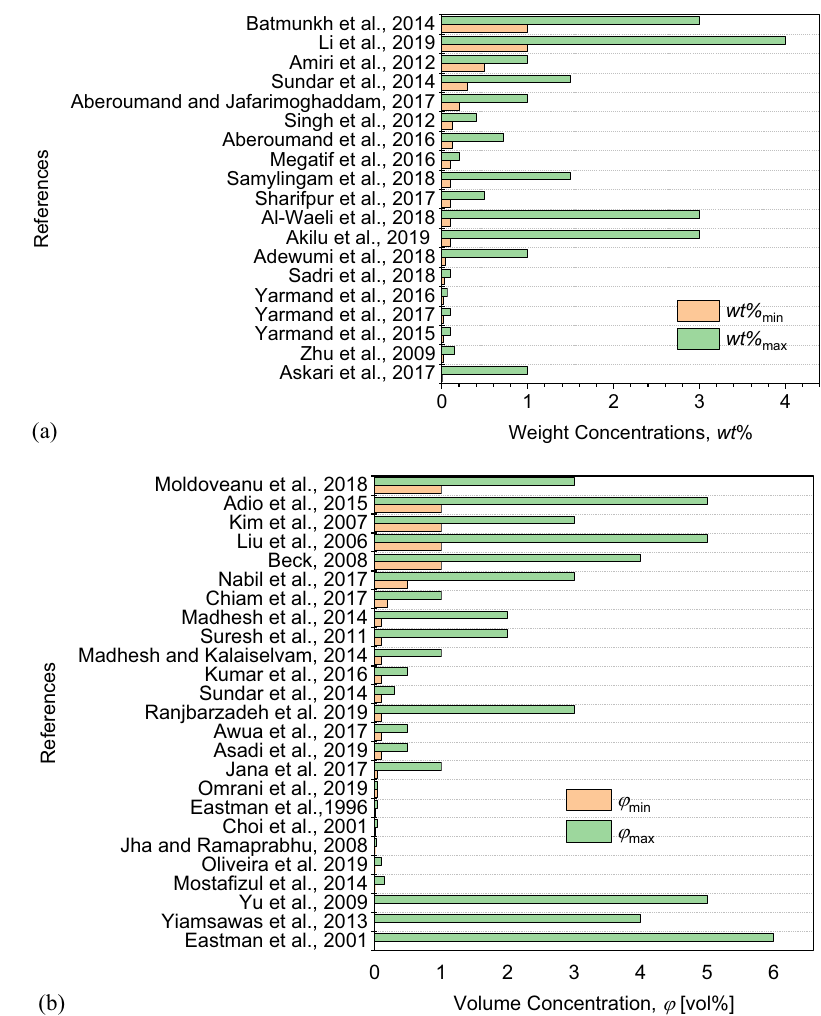
Figure 11: Range of weight and volume concentrations: ( a ) weight concentrations and ( b ) volume